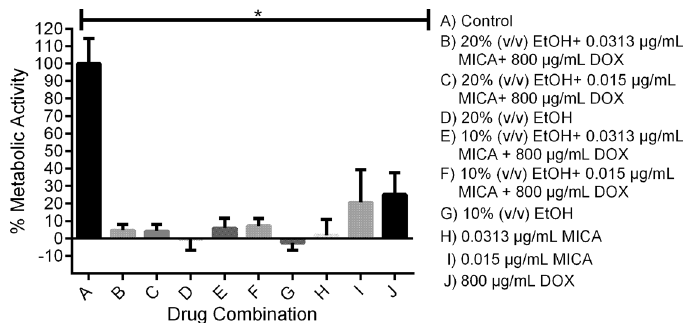
Fig 1. Prevention of C . albicans SC5314 biofilm formation on silicone disks. Potential lock solutions are highly effective in preventing the formation of C . albicans biofilms on silicone. Planktonic C . albicans cells were incubated on silicone for 24 hours at 37°C with potential lock solution candidates. Metabolic activity was measured using XTT reduction and untreated vs drug treated groups were compared using a one-way ANOVA. * indicates p value of < 0 . 05